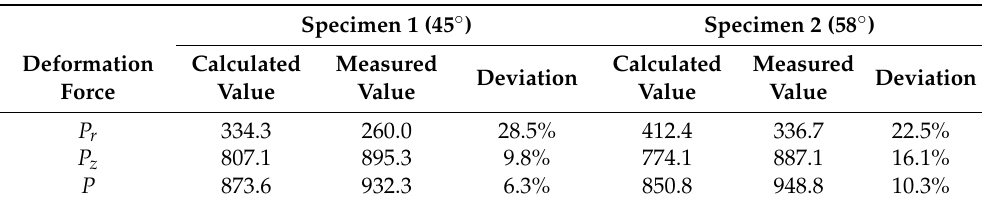
Table 3. Comparison between the theoretically calculated value of the deformation force and its actual measured value. Specimen 1 (45 ◦ ) Specimen 2 (58 ◦ ) Deformation Calculated Force